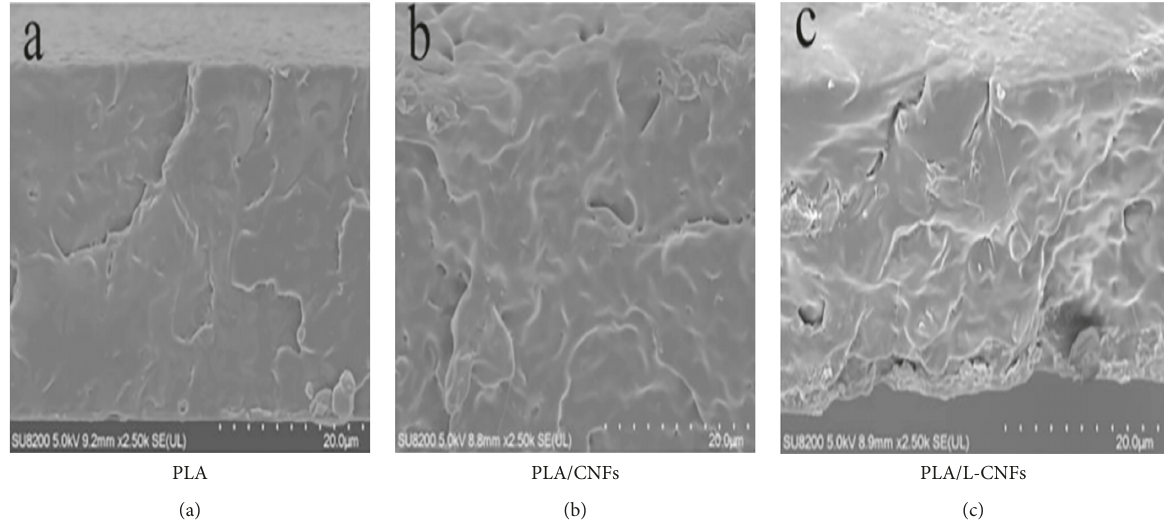
Figure 6: SEM photographs of (a) polymer, (b) polymer composite without lignin, and (c) lignin-containing biocomposite [218] (Copyright @ 2018 MDPI under CC BY 4.0).